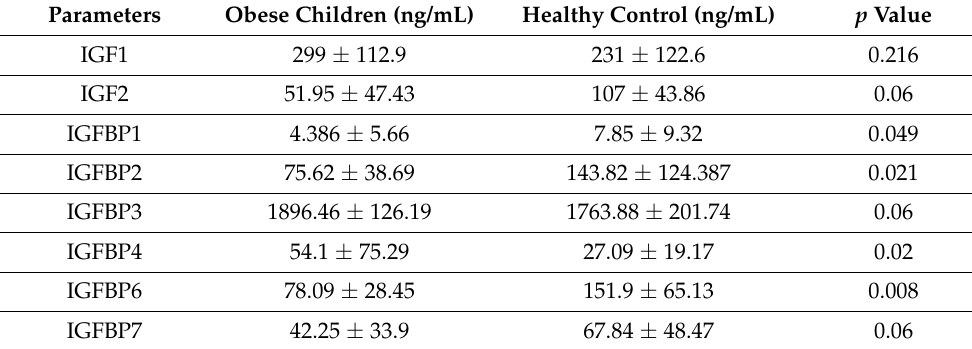
Table 3. IGF-1, -2 and IGFBP-1, -2, -3, -4, -6, and -7 mean concentrations: comparison of obesity group (OB) and healthy control (HC). Values are presented as mean ± standard